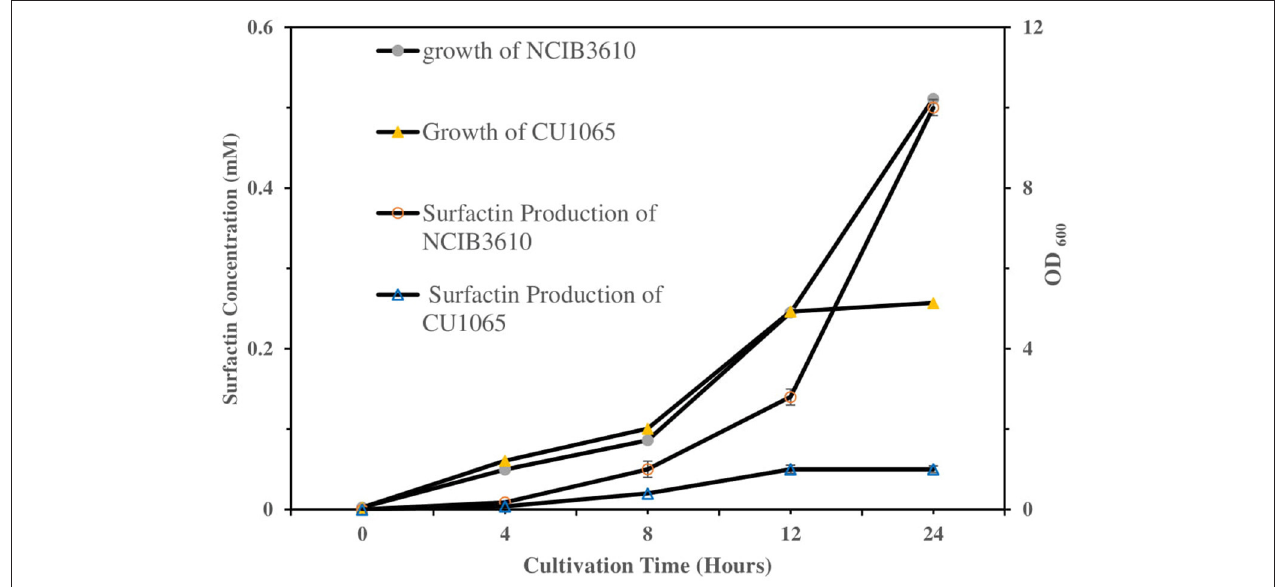
FIGURE 6 | Comparison of the bacterial growth and surfactin production of NCIB3610 and CU1065 strains as a function of the cultivation time. Each of supernatant samples was analyzed by HPLC.